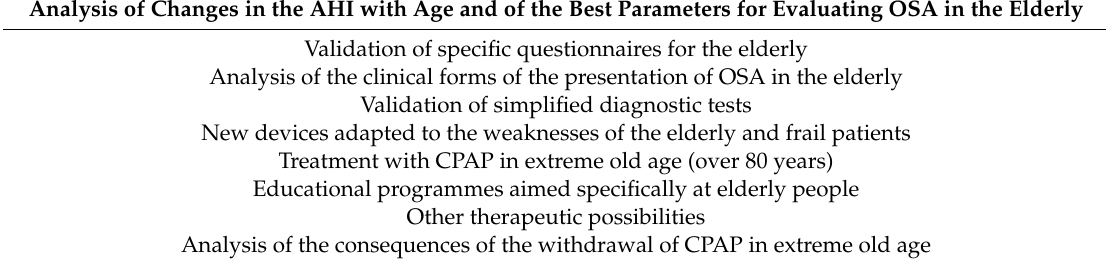
Table 3. Future challenges in sleep apnoea in elderly